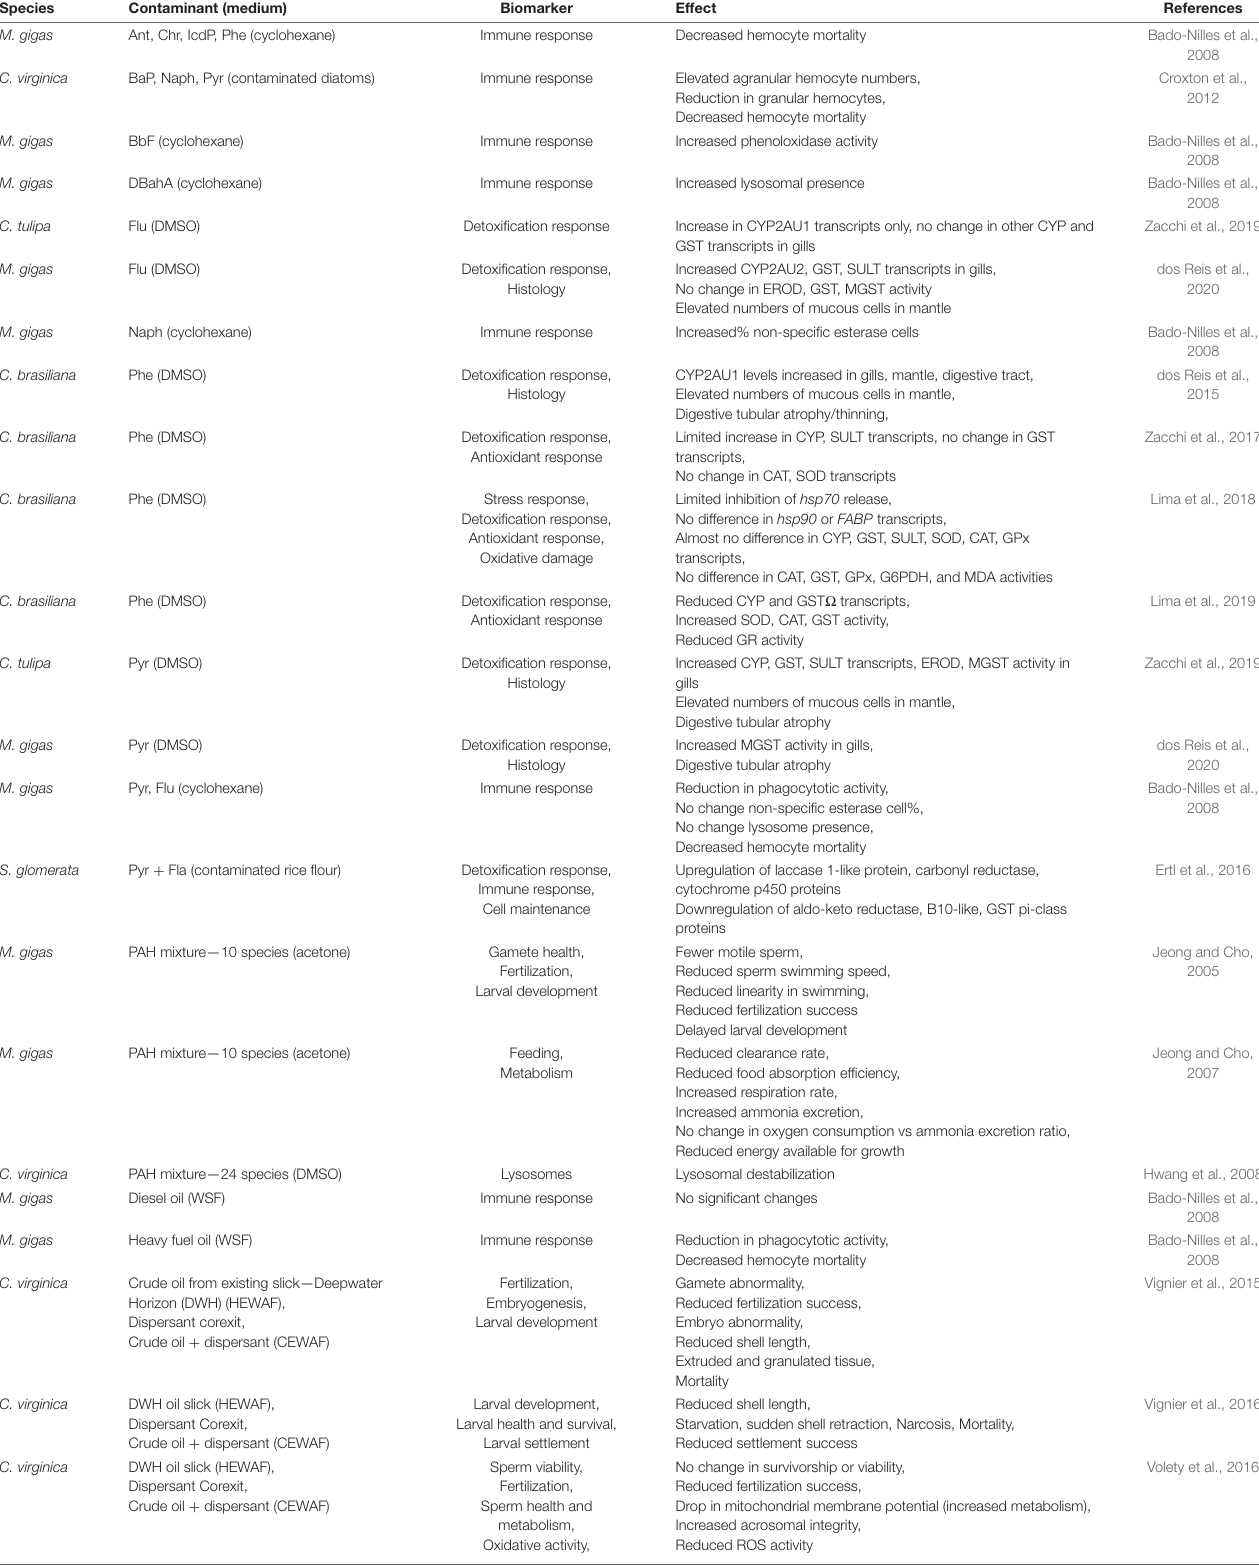
TABLE 1 | A summary of the results of the lab tests on the toxicities of PAHs is organized here, sorted by contaminant.